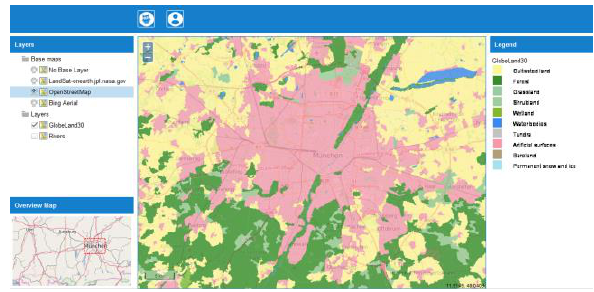
Figure 1. WebGIS test environment